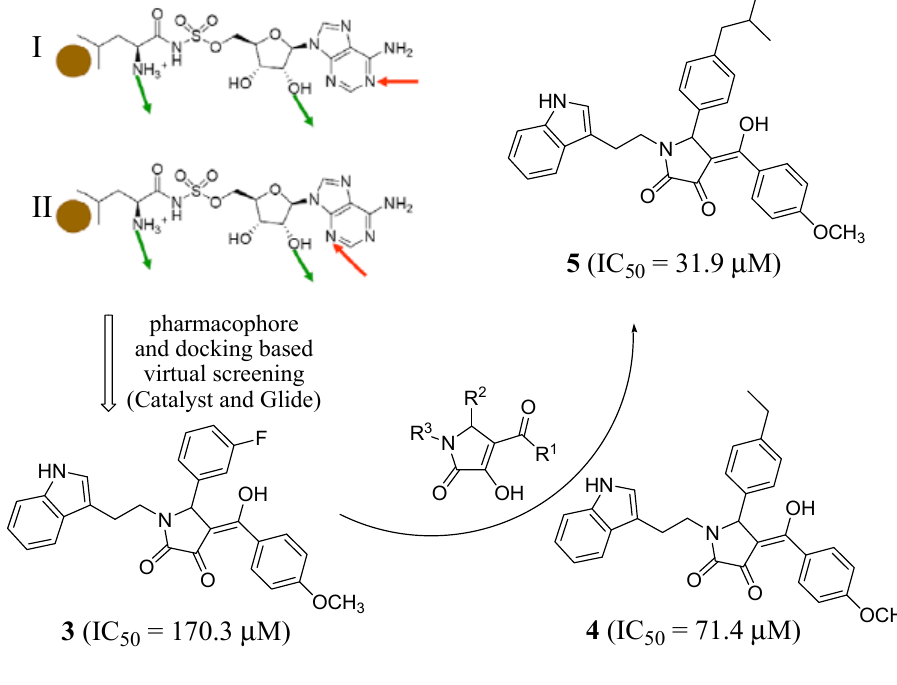
Figure 2. Scheme used in the identification of LeuRS inhibitors. Pharmacophores I and II: the hydrophobic site is colored as orange sphere, hydrogen bond donor is colored as green arrow, hydrogen bond acceptor is colored as red